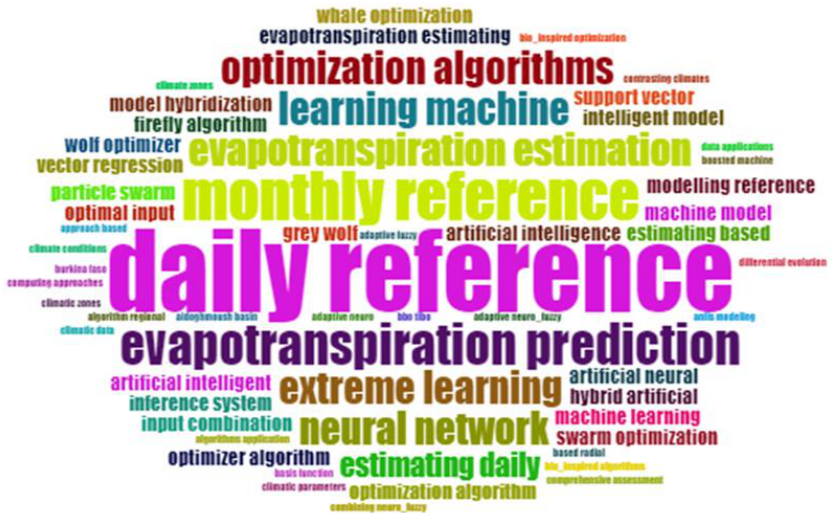
Figure 4. A delivers key terms from the research